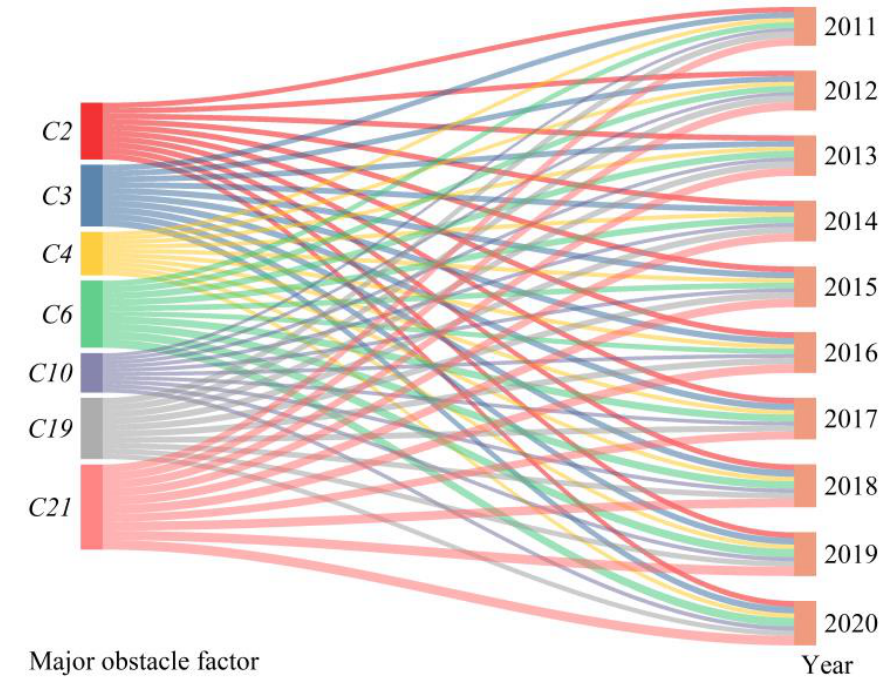
Figure 5. Analysis of the main obstacles to the WRCC of Shihezi from 2011 to 2020.